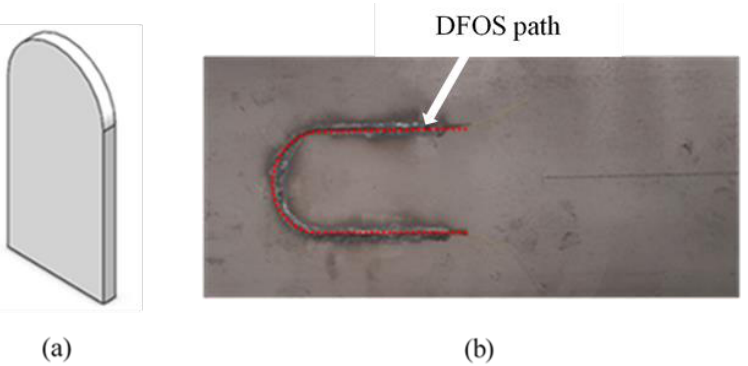
Figure 7. Preparation of specimen: ( a ) Guide used for mounting the DFOS; ( b ) DFOS path on the surface of the specimen.